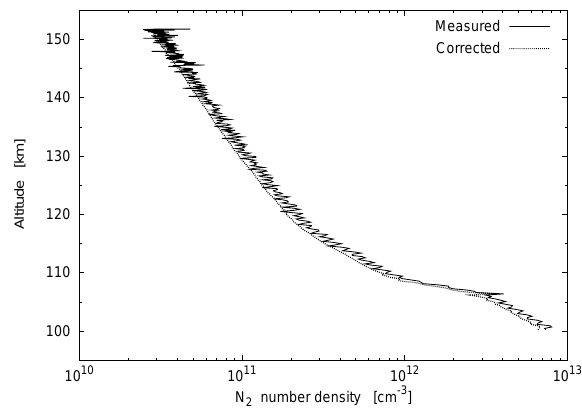
Fig. 10. Altitude profiles of the measured and corrected